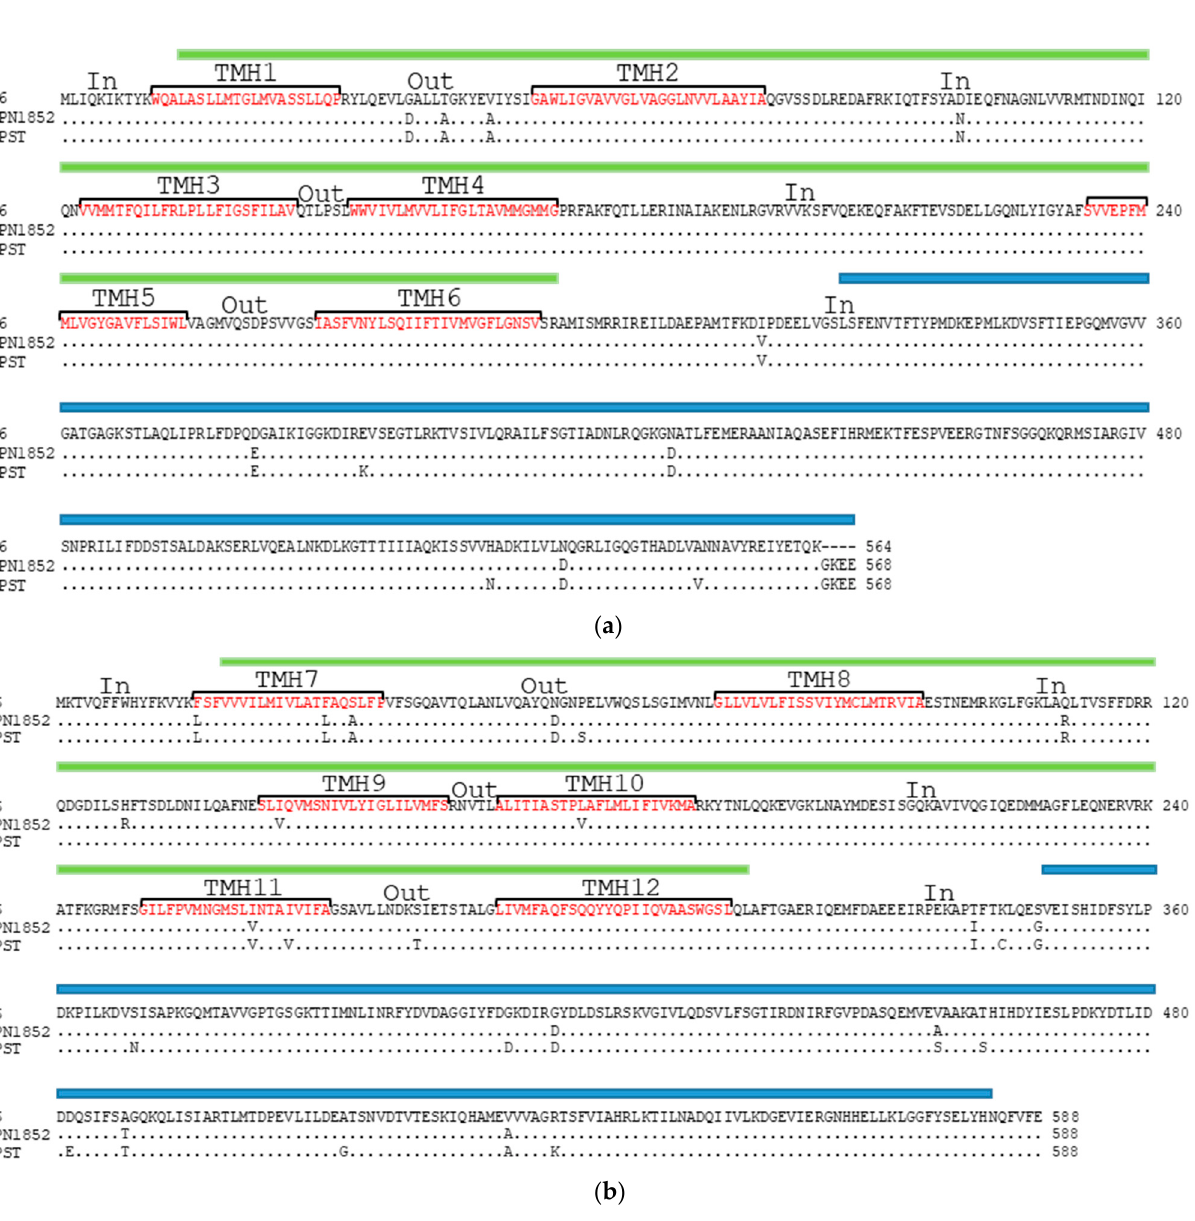
Figure 3. Comparison of PatA ( a ) and PatB ( b ). Multiple sequence alignment of proteins from R6, SPN1852 and SPST. R6 was taken as reference. Identical residues in SPN1852 and SPS T are illustrated by dots and only residues differing from R6 are shown. Predicted domains using ScanProsite (https://prosite.expasy.org/scanprosite/ (accessed on 22 August 2022)): transmembrane domain (green) and ATP-binding domain (blue). Transmembrane alpha-helixes (TMH) predicted by https://dtu.biolib.com/DeepTMHMM (accessed on 14 November 2022) are labeled in red and numbered from 1 to 6 in PatA, and from 7 to 12 in PatB. Extracellular (Out) and intracellular (In) loops are indicated.